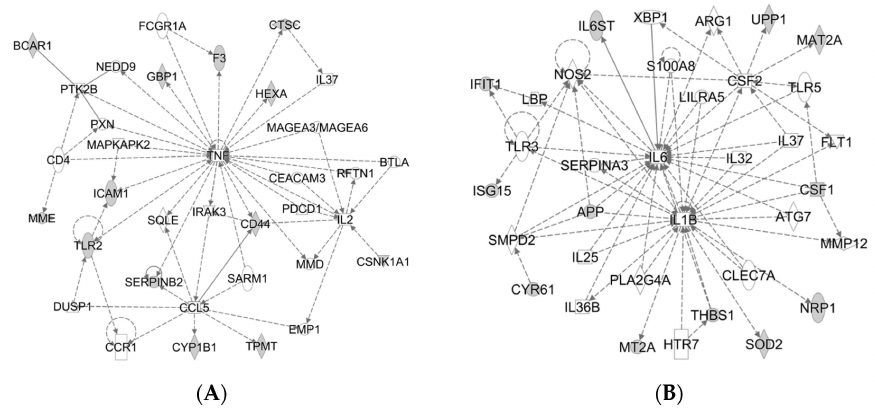
Figure 2. Biological pathways analysis of differentially expressed proteins in HH4 cells. ( A ) Top network functions of cell-to-cell signaling and interaction, inflammatory response, cellular movement and ( B ) immune cell trafficking using Ingenuity Pathways Analysis (IPA). Solid lines: direct known interactions. Dashed lines: suspected or indirect interactions. White: proteins known to be in the network but not identified in our study.